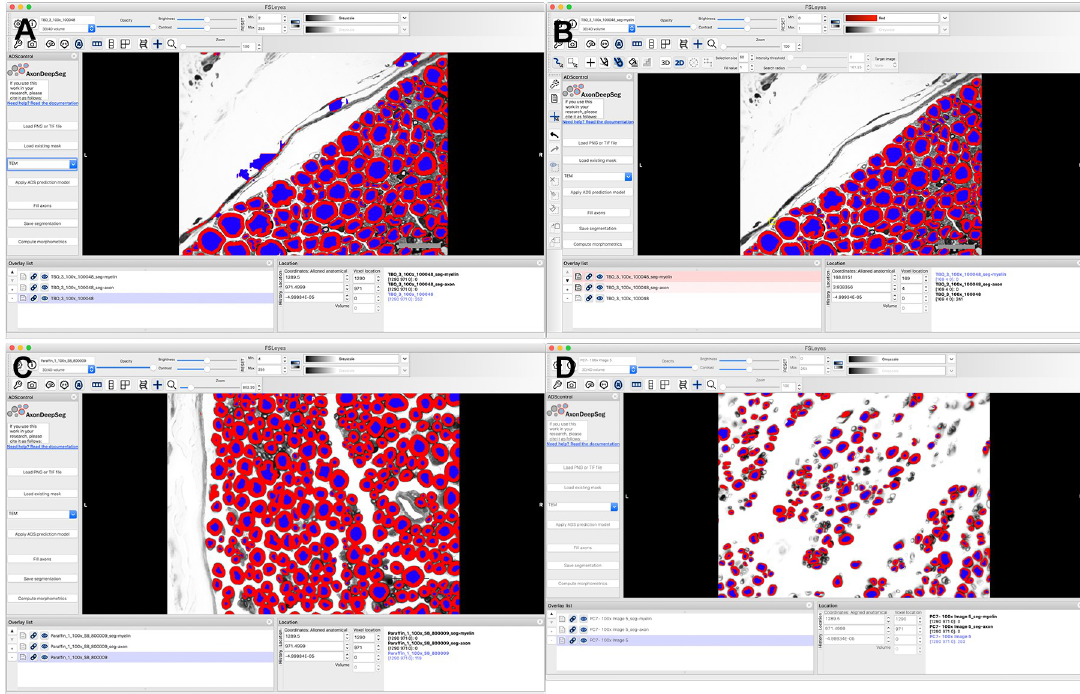
Fig 2. Representative screen shots showing user interface of AxonDeepSeg (ADS). (A) .tiff images were imported individually into the program, resolution was defined, and transmission electron microscopy was chosen as it produces dark myelin and lighter axons, as in light microscopy. Segmentation was then performed automatically, creating different layers for the axons and myelin. (B) Minimal manual correction was performed to remove objects mislabeled as axons. Histomorphometric measurements and axon count were then calculated by pressing the “Compute morphometrics” button, and a .csv file with these values was generated and segmented images were saved. (A) and (B) are micrographs of na ï ve nerves prepared in toluidine-resin protocol. (C) Micrograph of na ï ve nerve, osmium- paraffin protocol. (D) Micrograph of regenerating nerve, osmium-paraffin protocol.